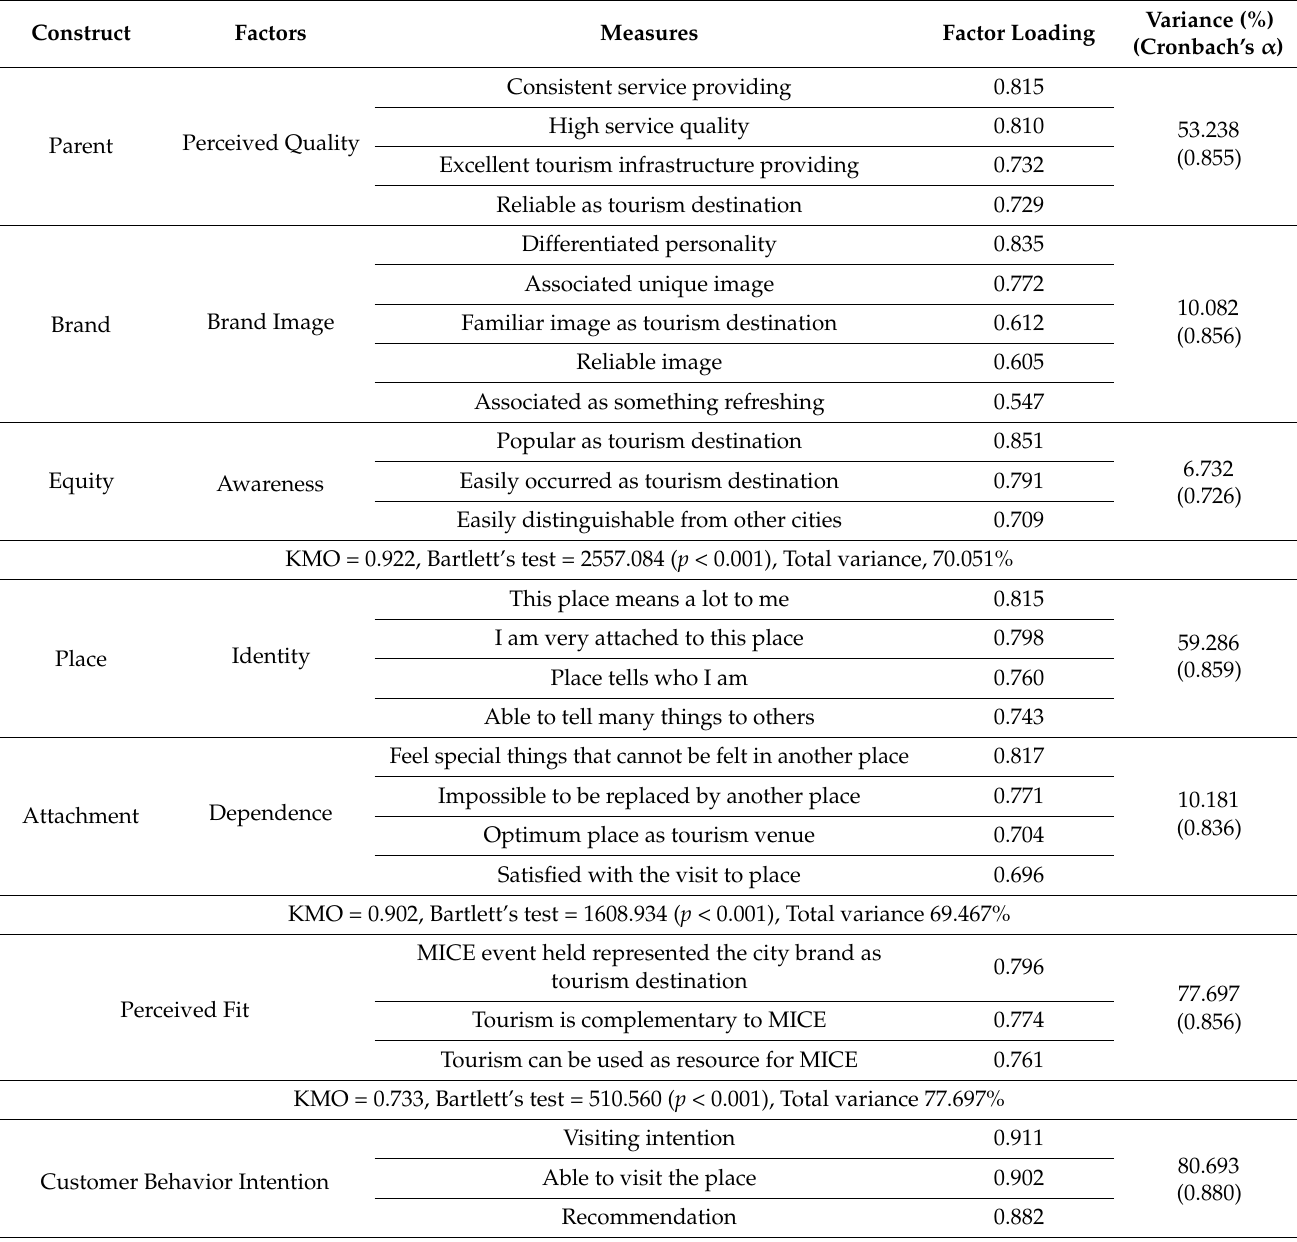
Table 1. Result of exploratory factor analysis